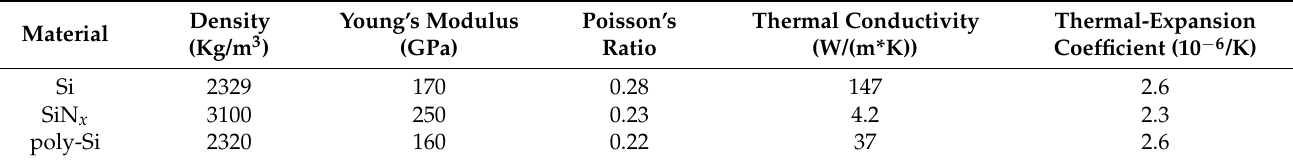
Figure 4. Simulation module: ( a ) exploded view, ( b ) vertical view. Table 2. Material parameter used in simulation.